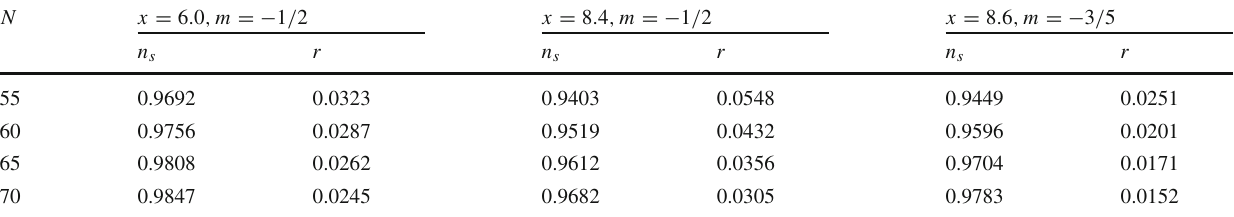
Table 2 For q = − 1 , n = 2, Inflationary observables for the different choices of the potential parameters ( x and m ) with variety of total number of e-folds, all the observables are consistent with the Planck (cid:3) 18